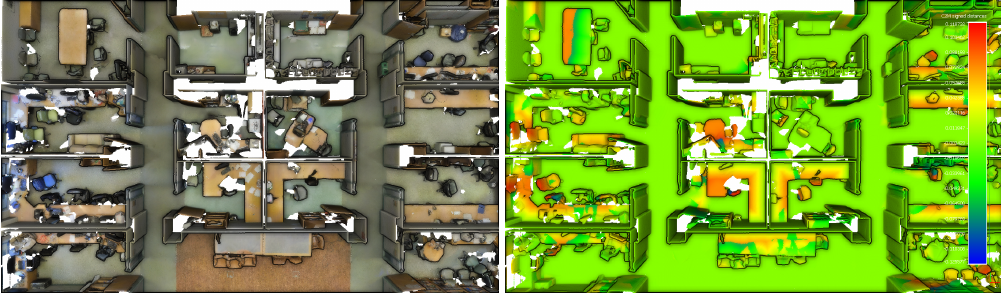
Figure 8. Overview deviation analysis: ( left ) a point cloud extract of Area 6, ( right ) the singed Euclidean distance between both datasets ranging from − 0.12 m in blue to 0.12 m in